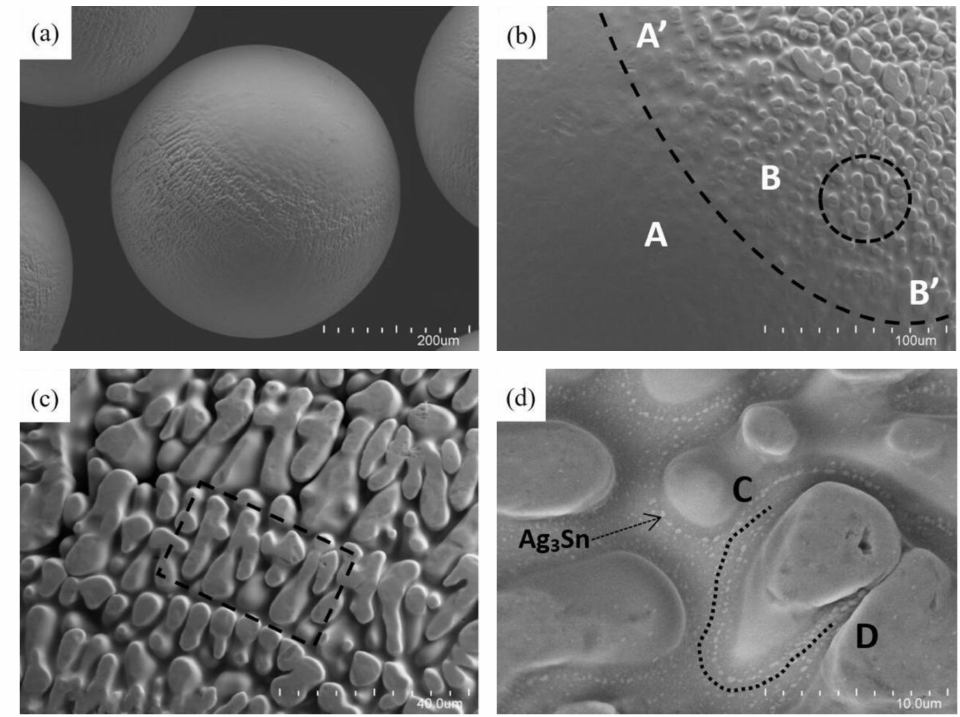
Figure 2. ( a ) The morphology of surface of BGA solder balls; ( b ) zoomed view of glossy area (A) and matt-like area (B) distinguished by dashed line A’B’; ( c ) the nearly rod-like humps that arranged periodically; ( d ) the nearly-oval humps and Ag 3 Sn particles that precipitated around a hump marked by dashed curve